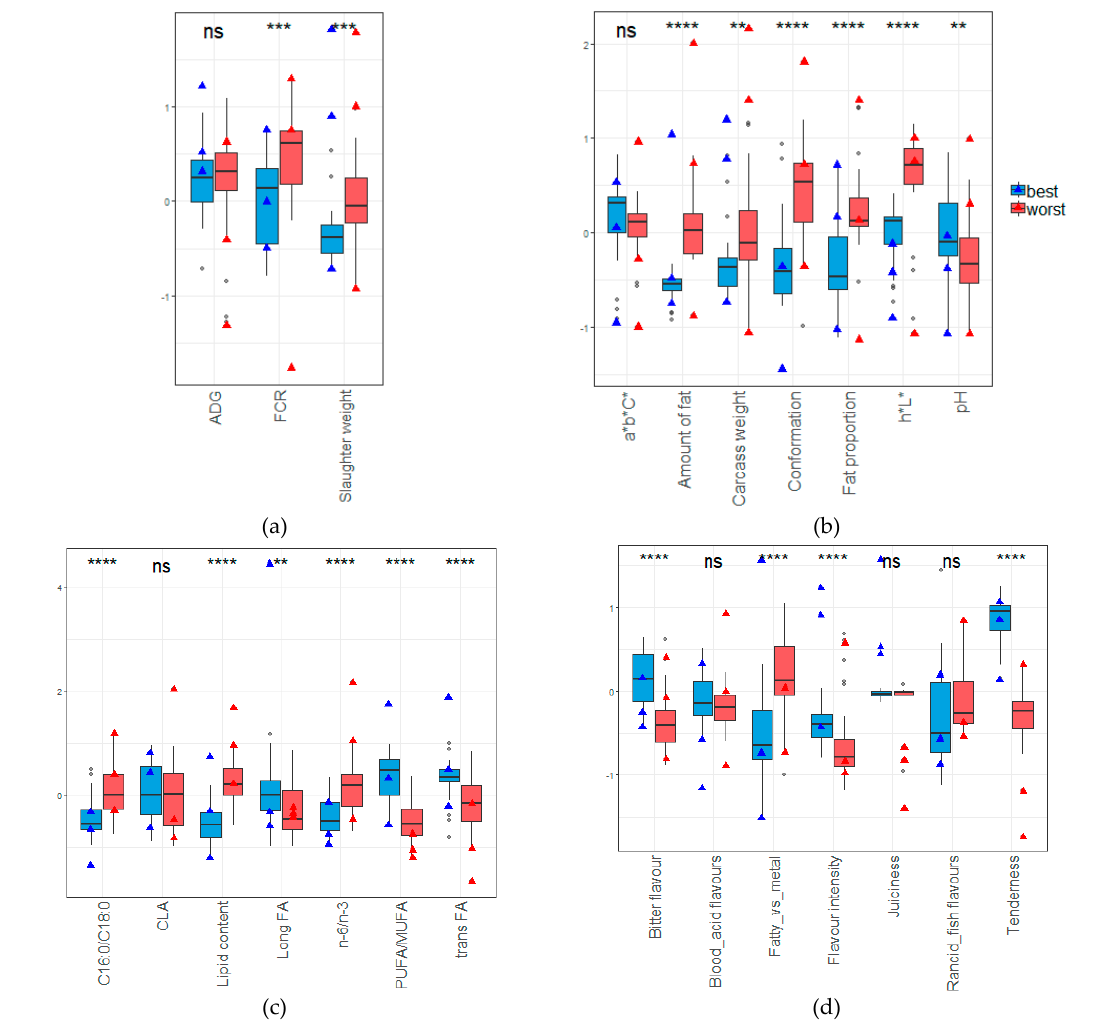
Figure 5. Comparison (boxplots) of the virtual animals traits between the worst (red) and the best (blue) profiles selected. The three best and worst real animals are added on the boxplots with triangles. For each variable, the result of a Wilcoxon test is provided (ns: no significant, **: p value < 0.01, ***: p value < 0.001, ****: p value < 0.0001). a : animal performances; b : carcass properties; c : nutritional quality; d : organoleptic quality.